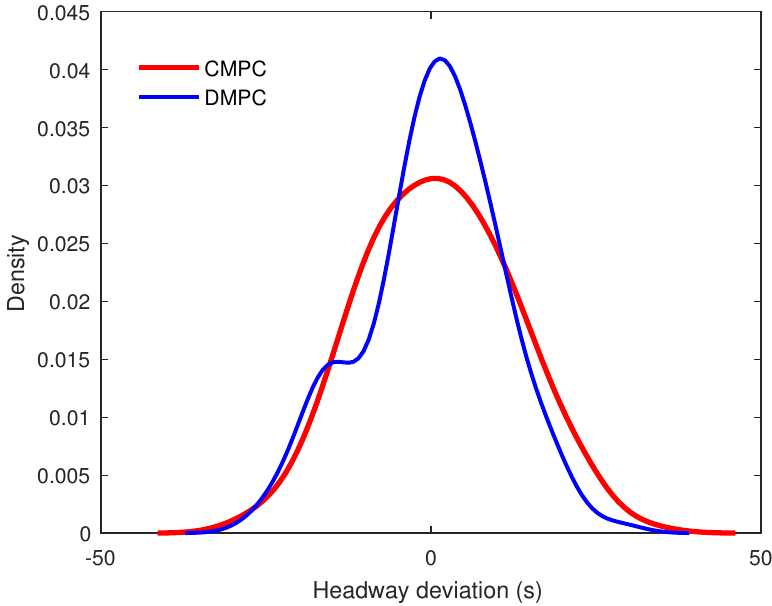
Figure 10. Distribution of headway deviation under Case 2 and Case